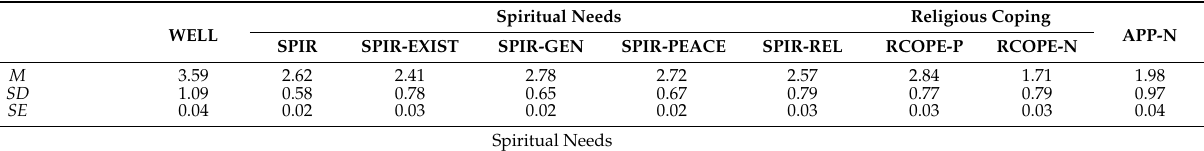
Table 2. Means, standard deviations, standard errors, and Pearson correlations between mental wellbeing, spiritual needs, religious coping and situation appraisal. Spiritual